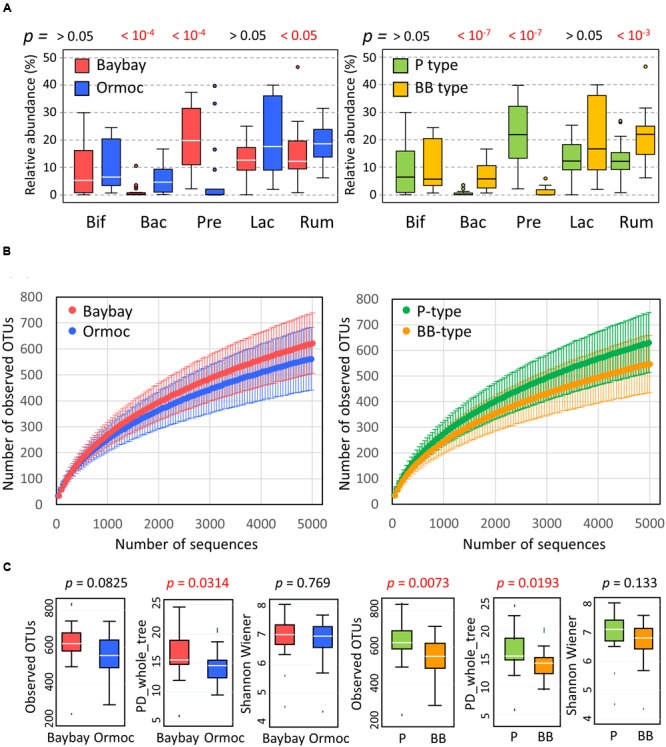
Characteristics of the gut bacterial community in Leyte children. (A) Relative abundance of five major bacterial families in fecal samples of Baybay (n = 24) and Ormoc (n = 19) children (left panel) and of P-type (n = 25) and BB-type (n = 18) children (right panel). The box plots show the smallest and largest values, 25 and 75% quartiles, the median, and outliers. Bif, Bifidobacteriaceae; Bac, Bacteroidaceae; Pre, Prevotellaceae; Lac, Lachnospiraceae, Rum, Ruminococcaceae. The Wilcoxon rank-sum test was performed to detect statistical differences between the two cities and the p-value is shown over the tested pair of box plots. (B) Rarefaction curve of the number of OTUs observed in samples from Baybay and Ormoc children (left panel) and from P-type and BB-type children (right panel). The number of OTUs was determined in each sample at each sequencing depth. The mean and standard deviation of each group are shown in the rarefaction plot. (C) Alpha-diversities of fecal bacterial community in individual samples from Baybay and Ormoc children (left three panels) and from P-type and BB-type children (right three panels). Individual OTU-composition data (OTU table) were rarified using 5,000 reads per participant in ten iterations. The number of observed OTUs, PD_whole_tree, and Shannon–Wiener index were calculated for each rarified OTU composition and averaged within the 10 iterations. The covariance of these calculated indices was computed for each country and was graphed as a box plot showing the smallest and largest values, 25 and 75% quartiles, the median, and outliers. It is noted that Shannon–Wiener index represents an entropic index but not itself diversity which should be expressed as the exponential of this value.